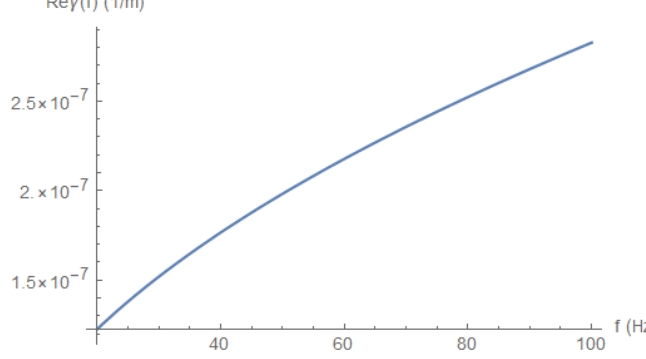
Figure 9. Re γ for low